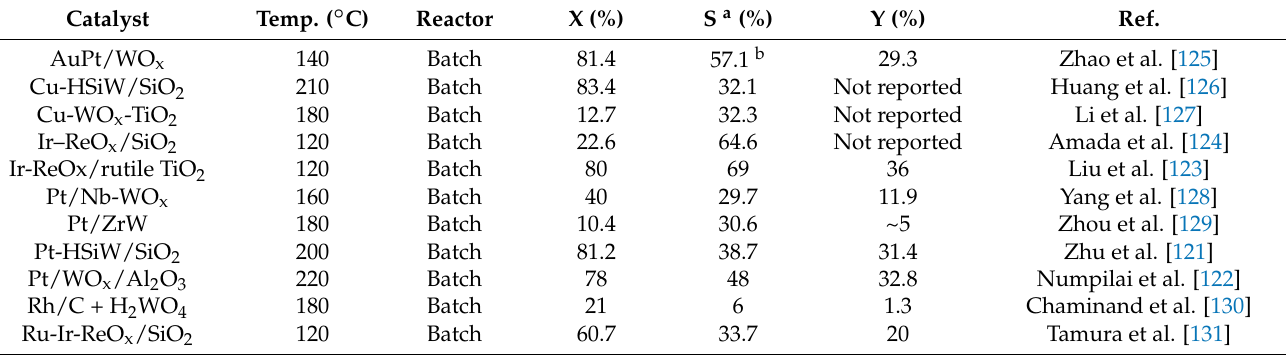
Table 3. Heterogeneous catalyst used for glycerol hydrogenolysis to